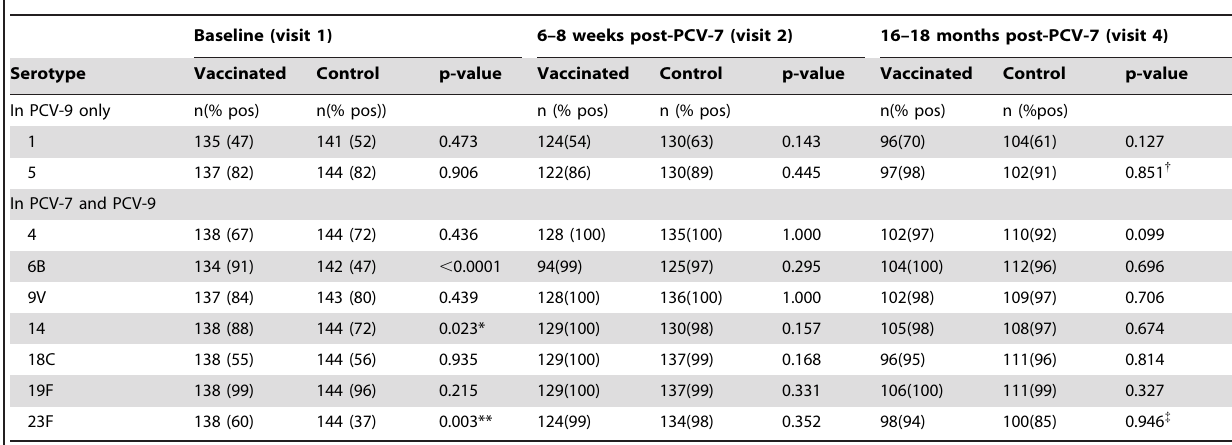
Table 2. Proportions of children aged 3–4 years with antibody concentration $ 0.35 m g/mL before and after vaccination with PCV-